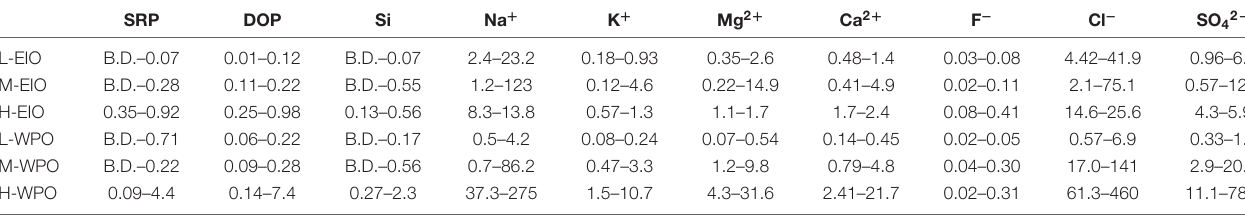
TABLE 1 | Range of phosphorus, dissolved silicate, and major ions in rainwater collected from two cruises.